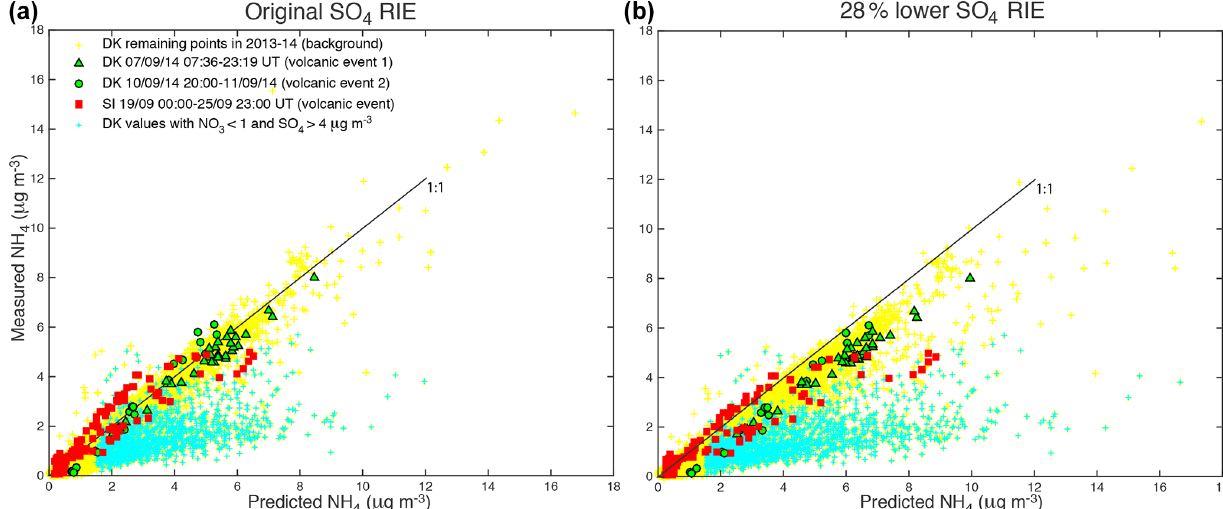
Figure 7. Scatter plot of measured ACSM NH 4 vs. predicted NH 4 mass concentration for the three volcanic events of air pollution recorded at SIRTA (in red) and Dunkirk/Port-East (in green, triangles and circles for volcanic events 1 and 2, respectively) in September 2014. Data in cyan indicate values associated with aerosols with mass concentrations of NO 3 < 1 and SO 4 > 4µgm − 3 . Yellow data correspond to the remaining ACSM values recorded in Dunkirk over 2013–2014, referring to background conditions. (a) Original and (b) 28% lower sulfate RIE